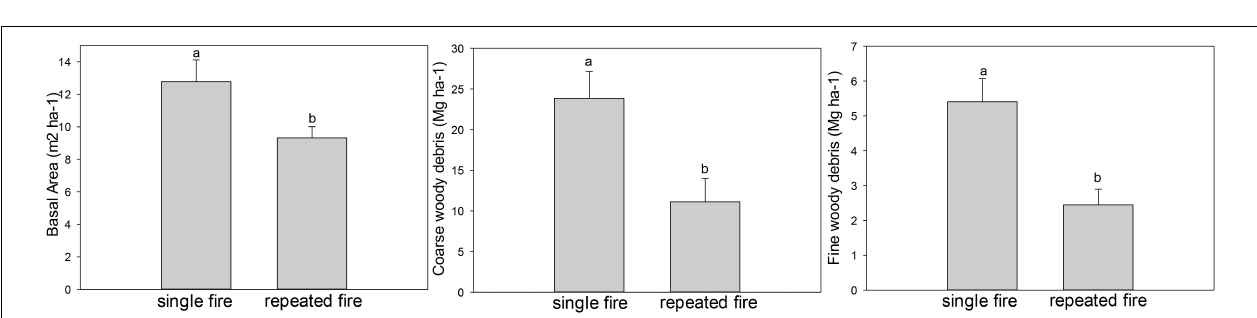
FIGURE 4 | Effect of years since fire on trees. (A) Total basal area (live and dead standing trees). (B) Live tree basal area. (C) Large-diameter snag density. (D) Live tree density. Open circles indicate individual stand replacing sites and “x”s indicate non-stand replacing fire and lines indicate natural logarithm fits for each class. Years since fire is a significant predictor of total basal area but only marginally significant for large-diameter snag density and not significant for live tree density ( Table 4 ).